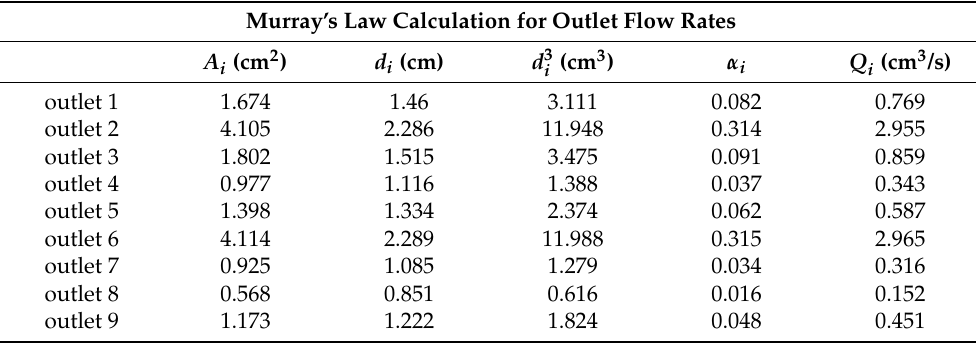
Table 5. Initial calculated flow rates at each outlet by Murray’s law for CT209